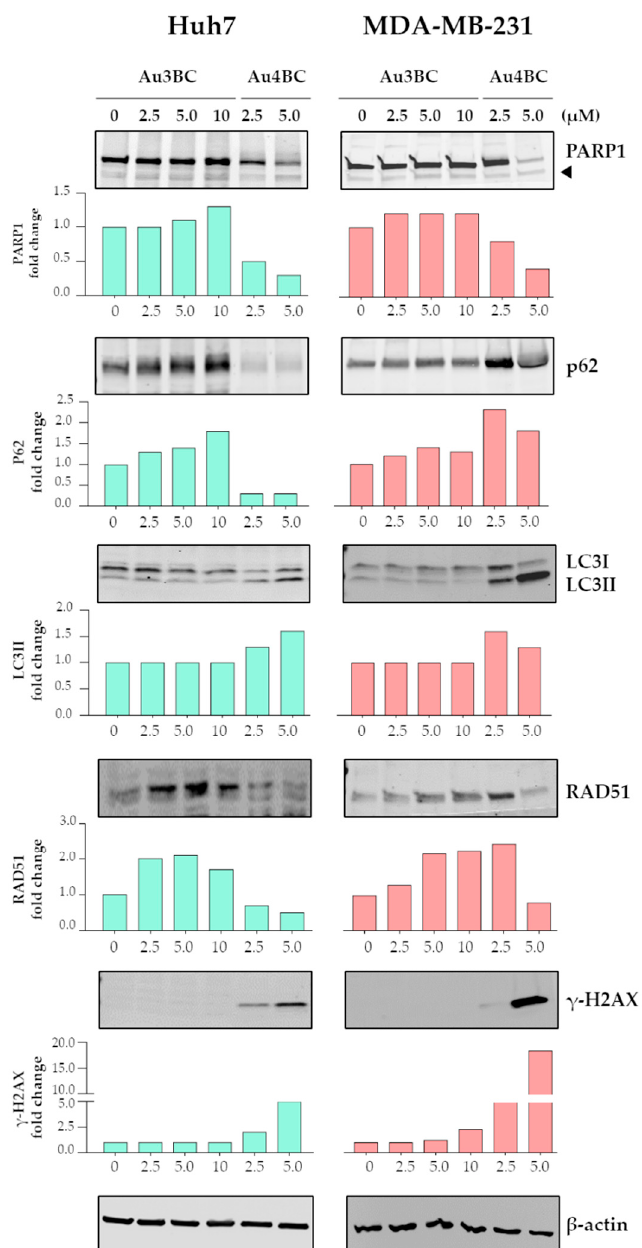
Figure 5. Immunoblotting evaluation of apoptosis, autophagy, and DNA damage-related protein expression in HCC and BC cells after Au3BC and Au4BC treatments. Cells were exposed to the indicated Au3BC and Au4BC concentrations for 72 h. The PARP1 fragment (85 kDa) is indicated by an arrowhead. For LC3 protein, the relative protein expression levels of LC3II were calculated. The numbers in the bar plots represent the ratio of the relevant protein normalized with β -actin, with vehicle-treated control samples arbitrarily set at